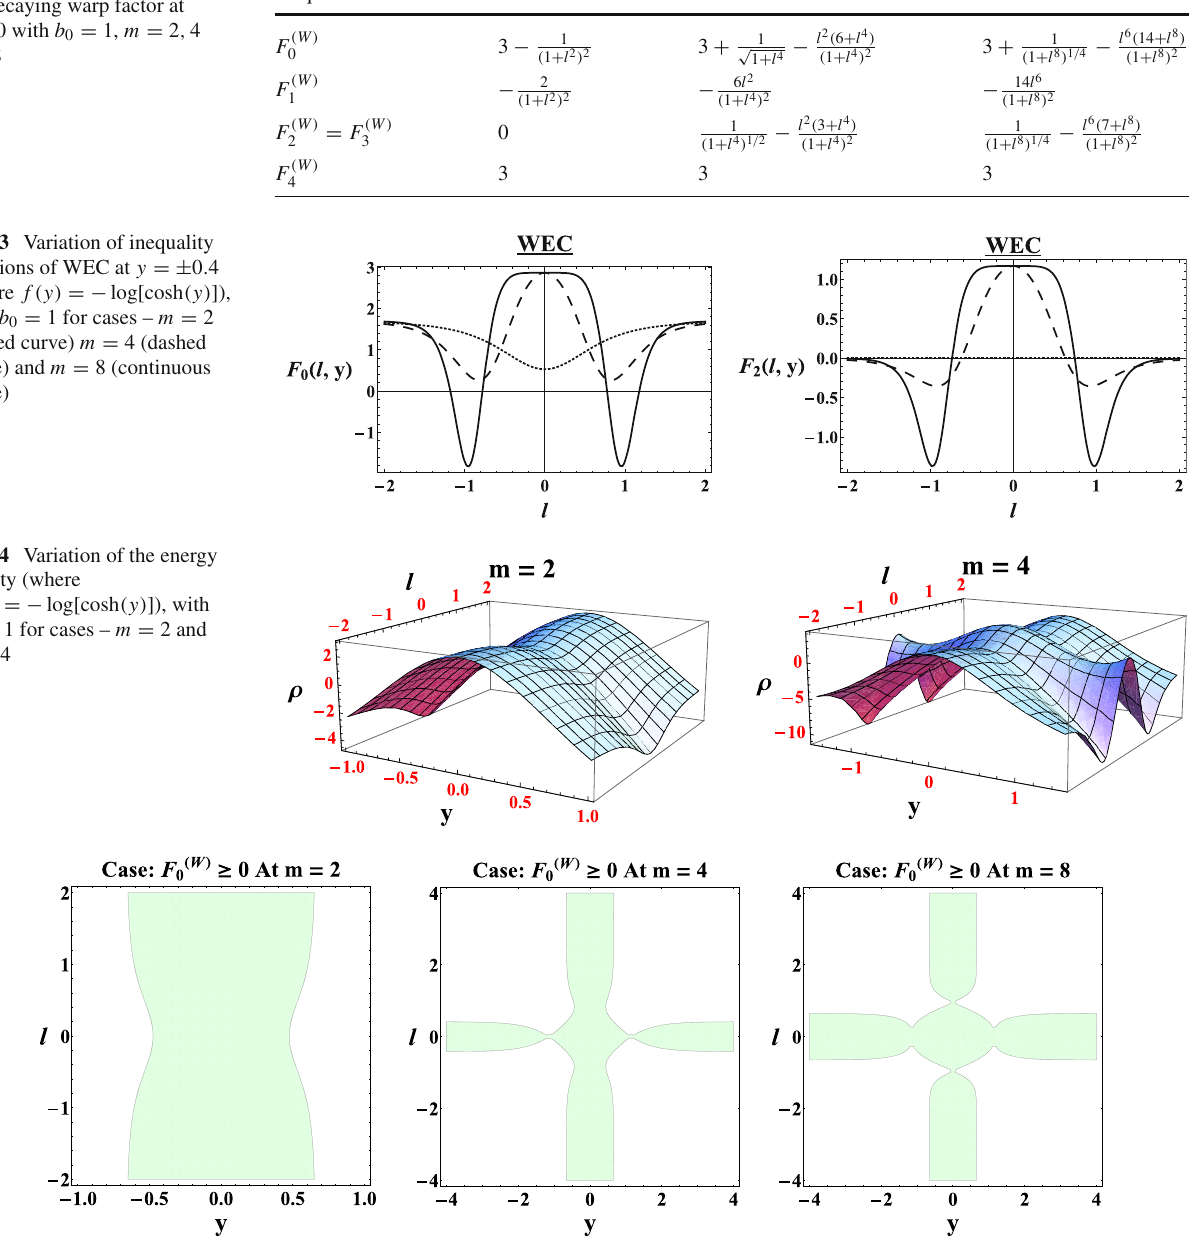
> 0 (shaded region), with f ( y ) = − log [ cosh ( y ) ] for m = 2 m = 4 and m = 8 with b 0